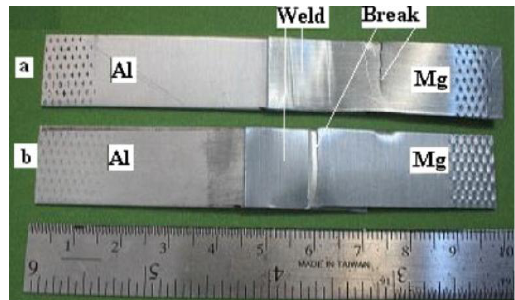
Figure 15. Shear tested samples of magnetic pulse welded Mg/Al joint